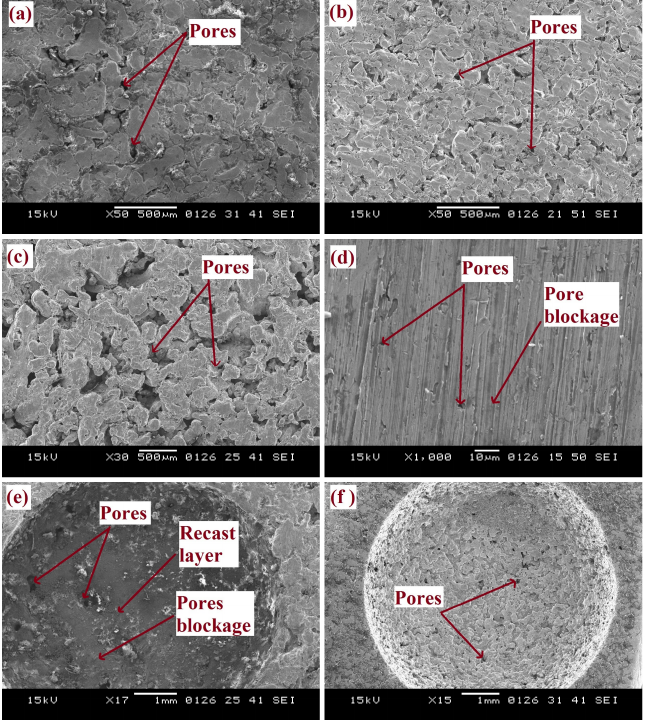
Figure 9. Porous stainless steel morphology: ( a ) 10 wt.% NaCl, ( b ) 20 wt.% NaCl, ( c ) 30 wt.% NaCl, ( d ) Conventional machining, ( e ) Pores blockage by EDM, and ( f ) EDM process at optimum